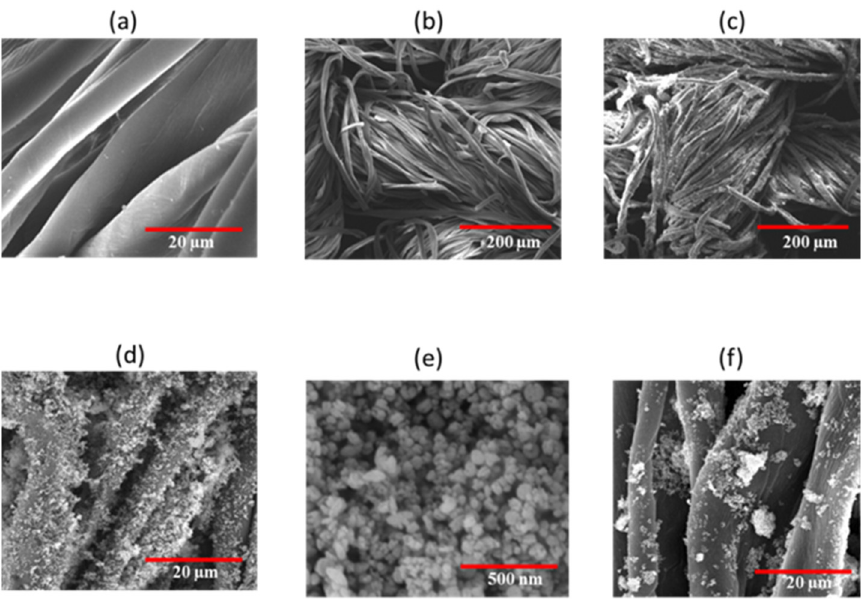
Figure 2. SEM images ( a , b ) pristine cotton, ( c – e ) sample 23, and ( f ) sample A.